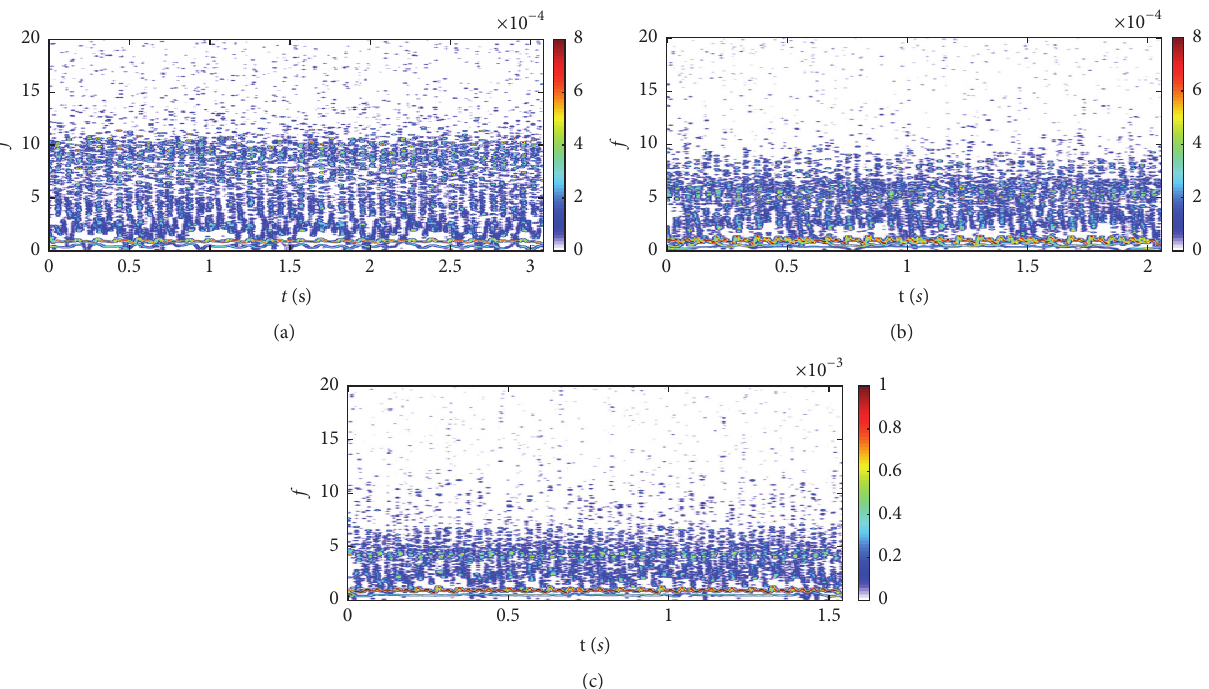
Figure 19: The time-frequency diagram of the system with the SFD mounted on the faulted bearing at (a) 100 rad/s and (c) 150 rad/s and (c) 200